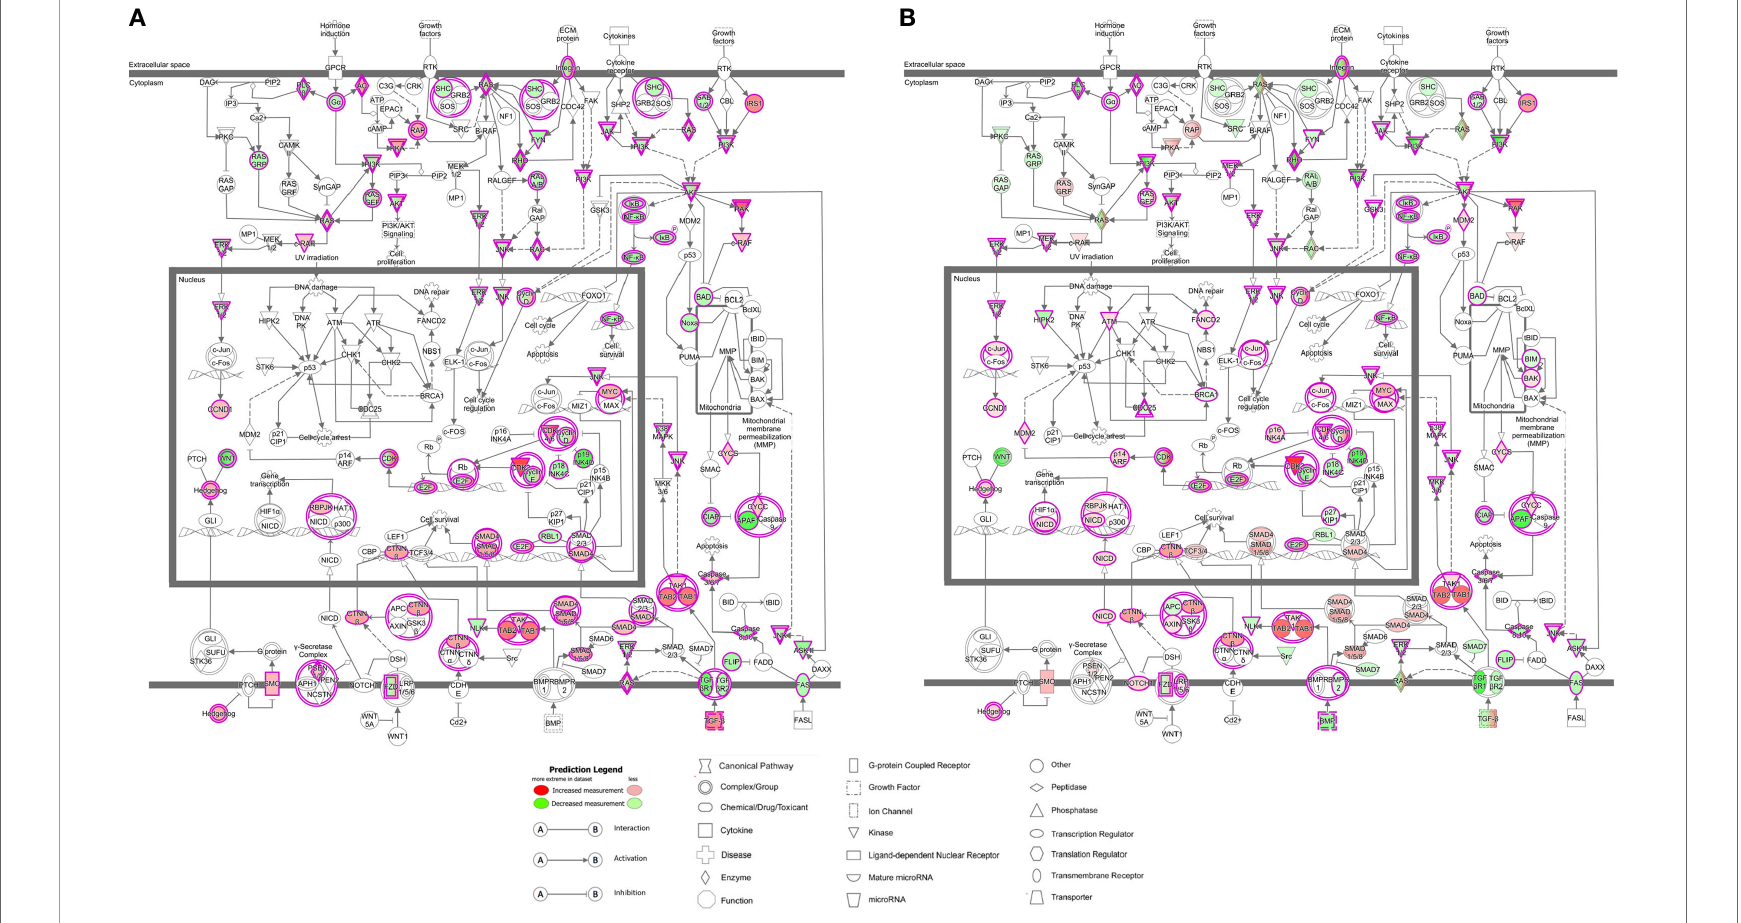
FIGURE 3 | LMTK2 KD affects molecular mechanisms of cancer in vehicle- (A) or TGF- b 1-treated (B) CFBE41o- cells. CFBE41o- cells transfected with siLMTK2 or siCTRL were treated with vehicle control or TGF- b 1 for 24h. Total RNA was isolated using Quick-RNA ™ MiniPrep kit (Zymo Research) and quanti fi ed on Illumina NextSeq 500 ’ s (Illumina). LMTK2 knockdown changed the expression of 91 genes encoding mediators of molecular mechanisms of cancer signaling pathway in vehicle-treated CFBE41o- cells (A) , and this number increased to 142 genes after TGF- b 1 treatment (B) . Image was obtained using the Ingenuity Pathway Analysis